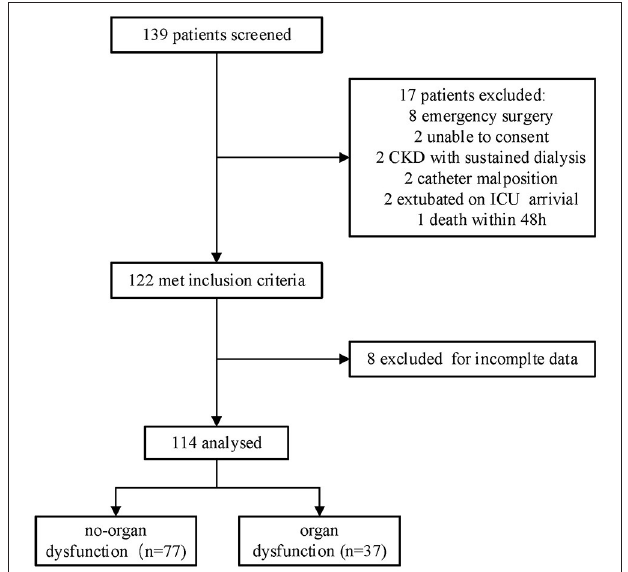
FIGURE 1 | Study flow-chart. CKD, chronic kidney disease.